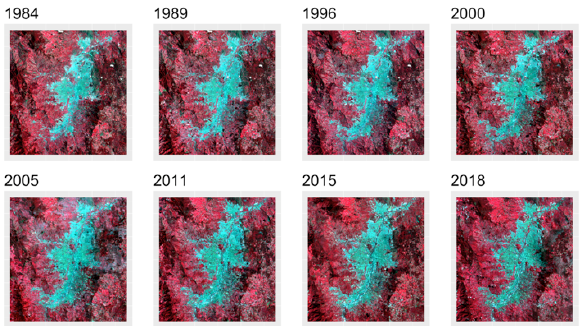
Figure 4. Infrared colour composites of the Landsat images.